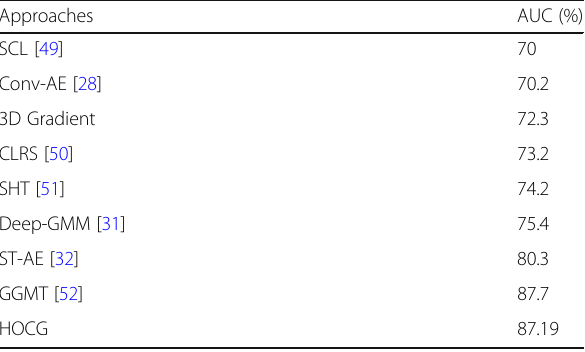
Table 6 Summary of the quantitative performance and comparison with the state-of-the-art approaches on the Avenue